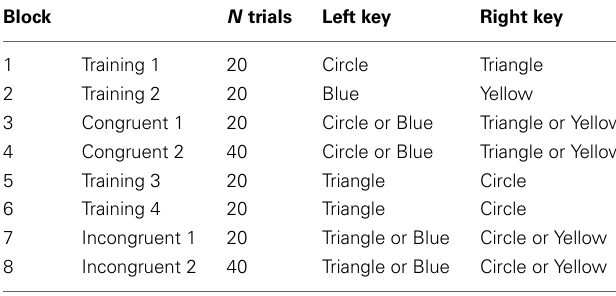
Table 1 | Order of blocks and response mappings for participants who did congruent trials first (example from IAT 1).